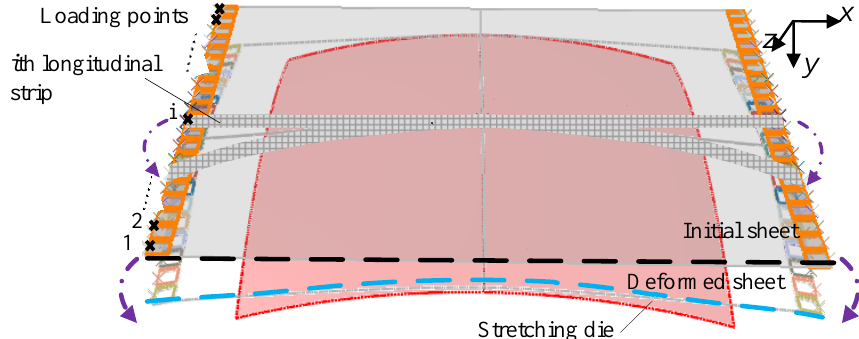
Figure 16. Geometric illustration for the loading trajectory at i th loading point.